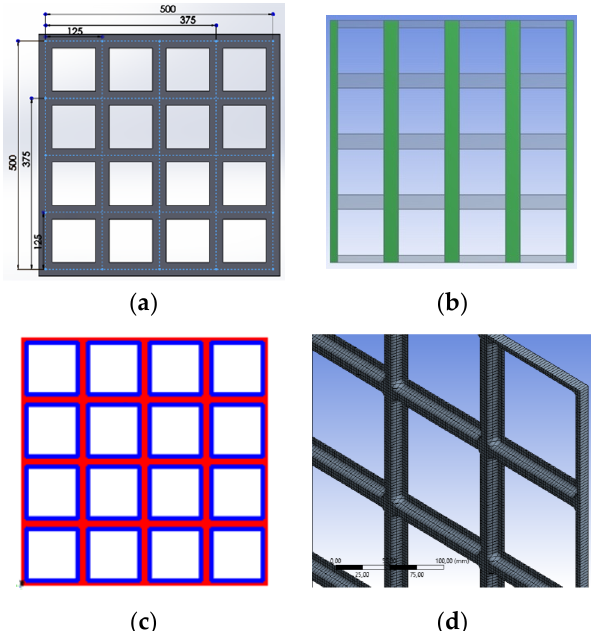
Figure 4. Details in sandwich discretization (in the case of rectangular grid): ( a ) the 500 × 500 mm base section; ( b ) vertical beams over respect to the horizontal ones; ( c ) sides where the thickness of the sandwich must decrease; ( d ) final mesh (also showing the thickness changes).